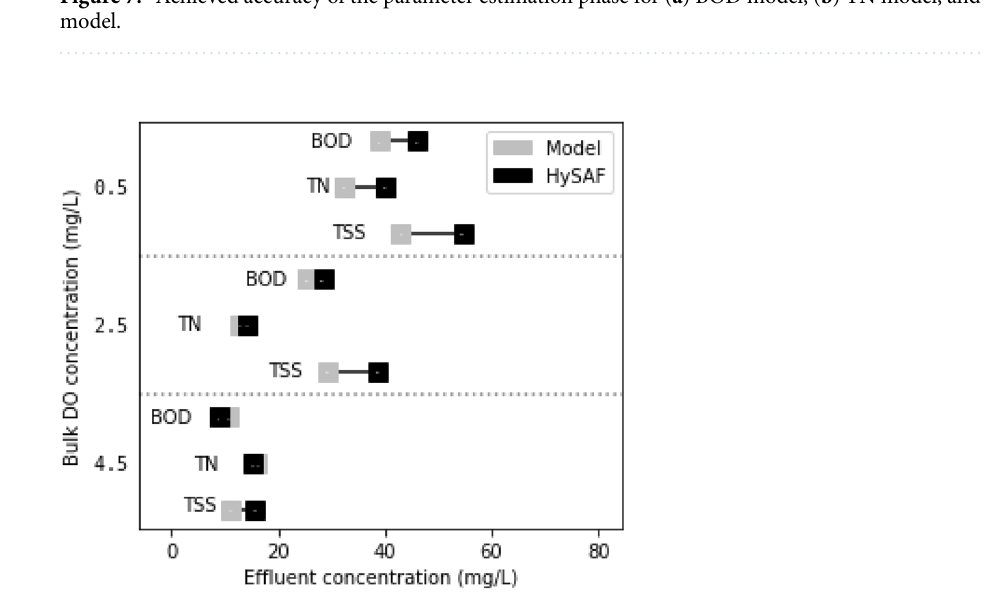
Figure 8. Accuracy of model calibration and validation with regards to effluent BOD, TN and